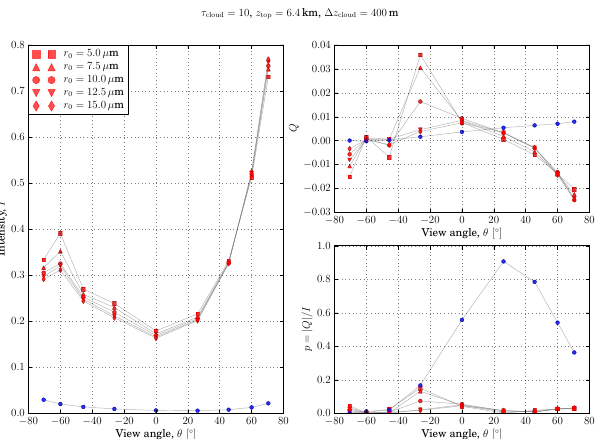
Figure 11. Same as Fig. 10 except that the Stokes component I is shown for a cloud of optical thickness of τ cloud =